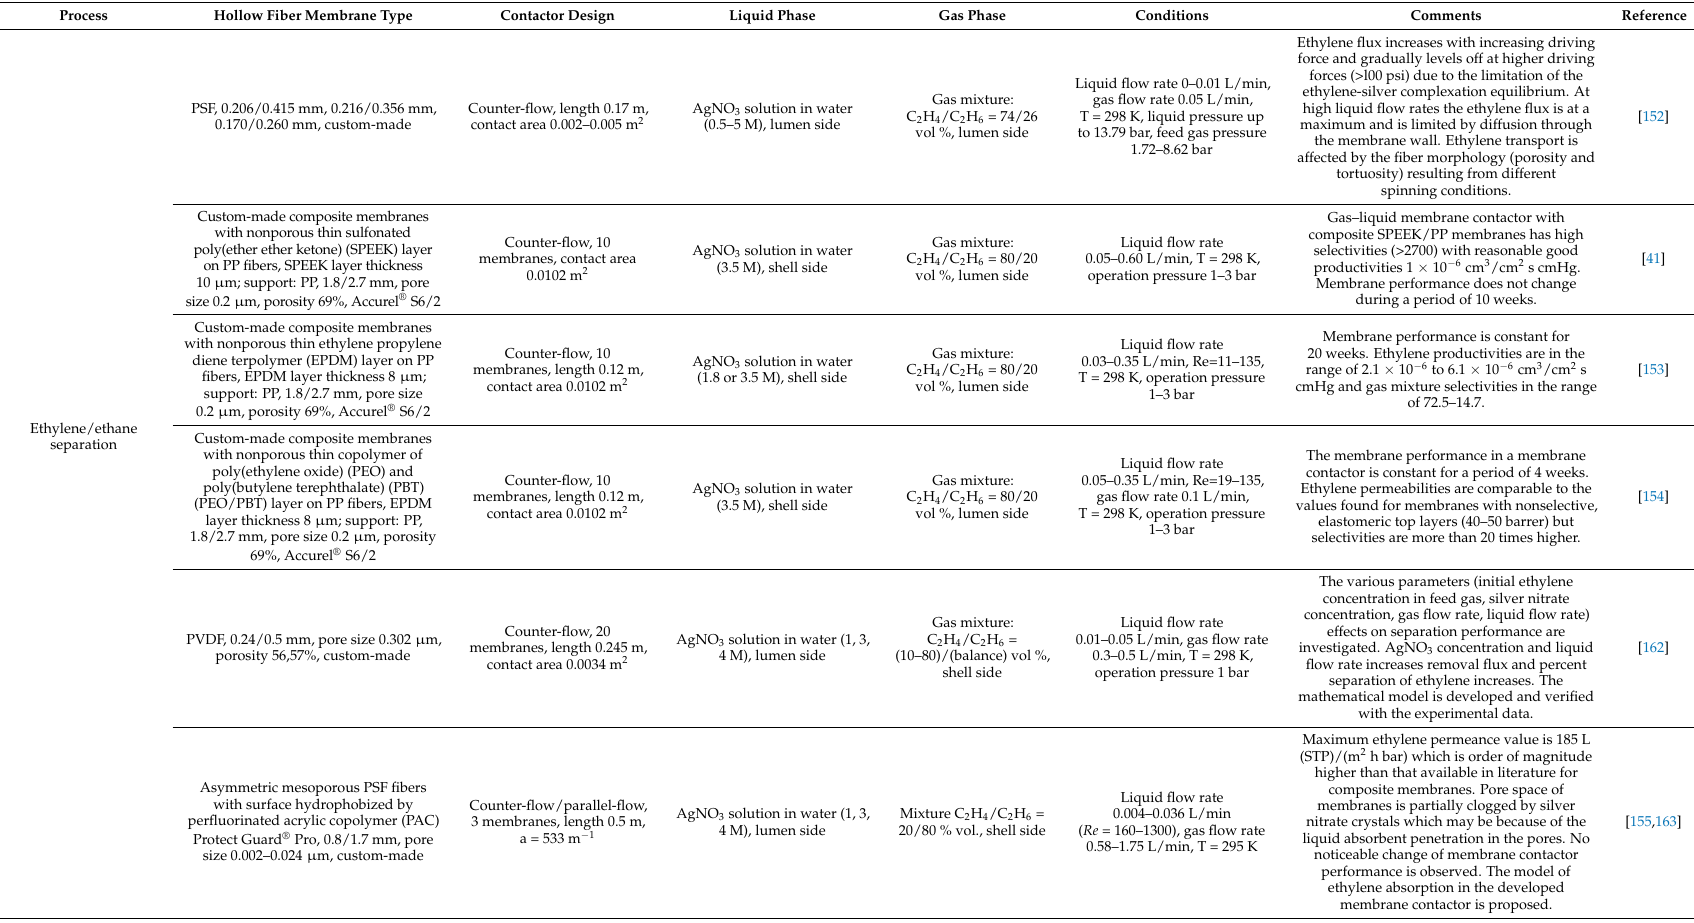
Table 7. Studies on olefin/paraffin